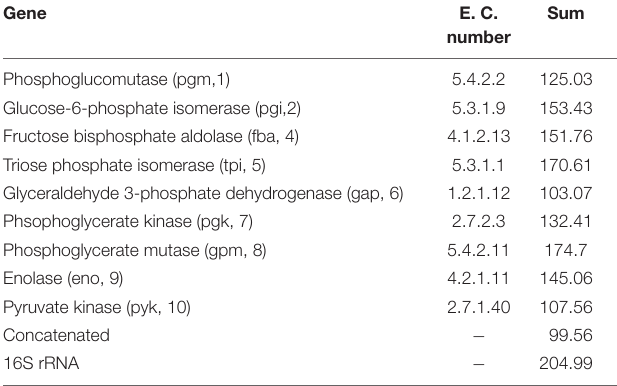
alignment had an algorithm setting of auto, a scoring matrix of BLOSUM80, a gap open penalty of 1.53, and an offset value of 0.123. For the first 16S rRNA alignment, the algorithm was set to auto, the scoring matrix was set to 100 PAM/k = 2, the gap open penalty was set to 1.53, and the offset value was set to 0.123. The